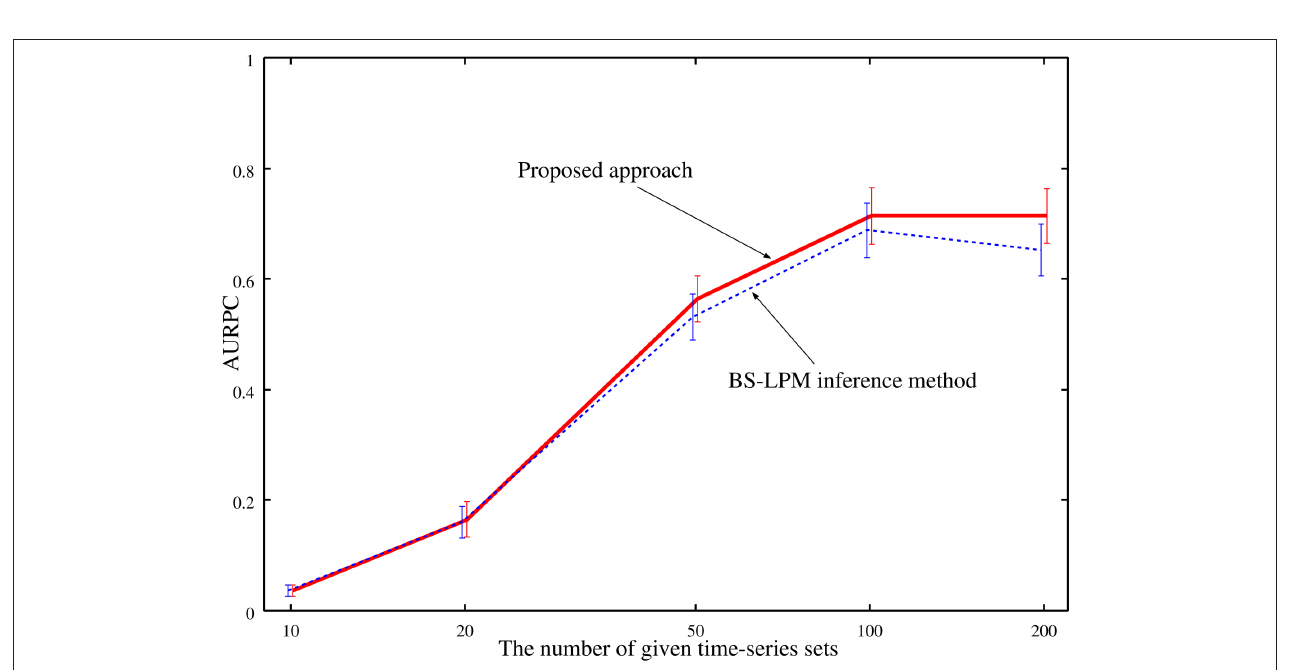
FIGURE 6 | The averaged AURPCs of the proposed approach (solid line) and the BS-LPM inference method (dotted line) in the experiments where different numbers of time-series sets were given.